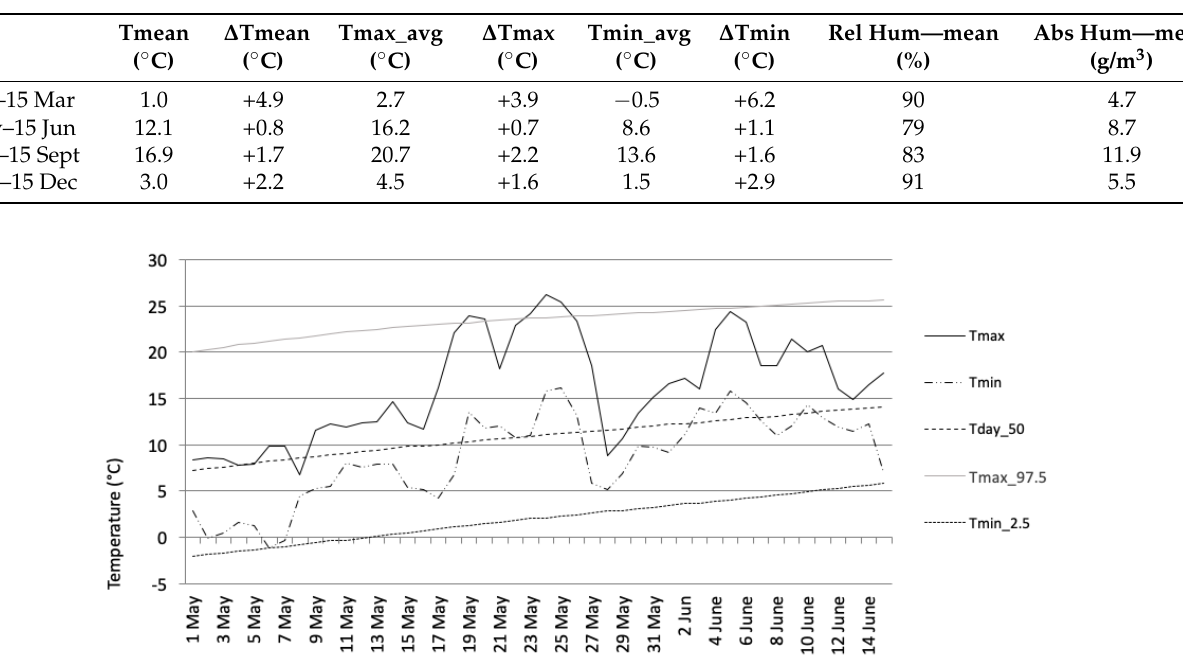
Table 1. Climate statistics taken from the Helsinki–Kaisaniemi weather station during the survey periods in 2014. Tmean = mean temperature, ∆ Tmean = deviation from the mean temperature from the normal climate (1981–2010), Tmax_avg = average daily maximum temperature, ∆ Tmax = deviation from the maximum temperature from normal, Tmin = average daily minimum temperature, ∆ Tmin = deviation from the minimum temperature from normal, Rel Hum = relative humidity, Abs Hum = absolute humidity.